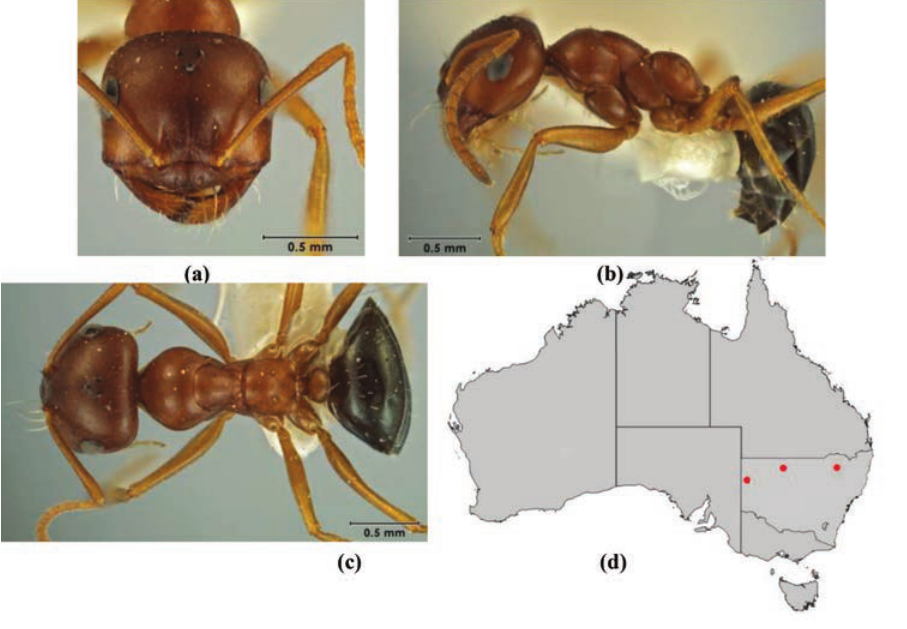
Figure 81. Melophorus hexidens sp. n.: holotype minor worker (ANIC32-066603–bottom ant) frons ( a ), profile ( b ) and dorsum ( c ); distribution map for the species ( d